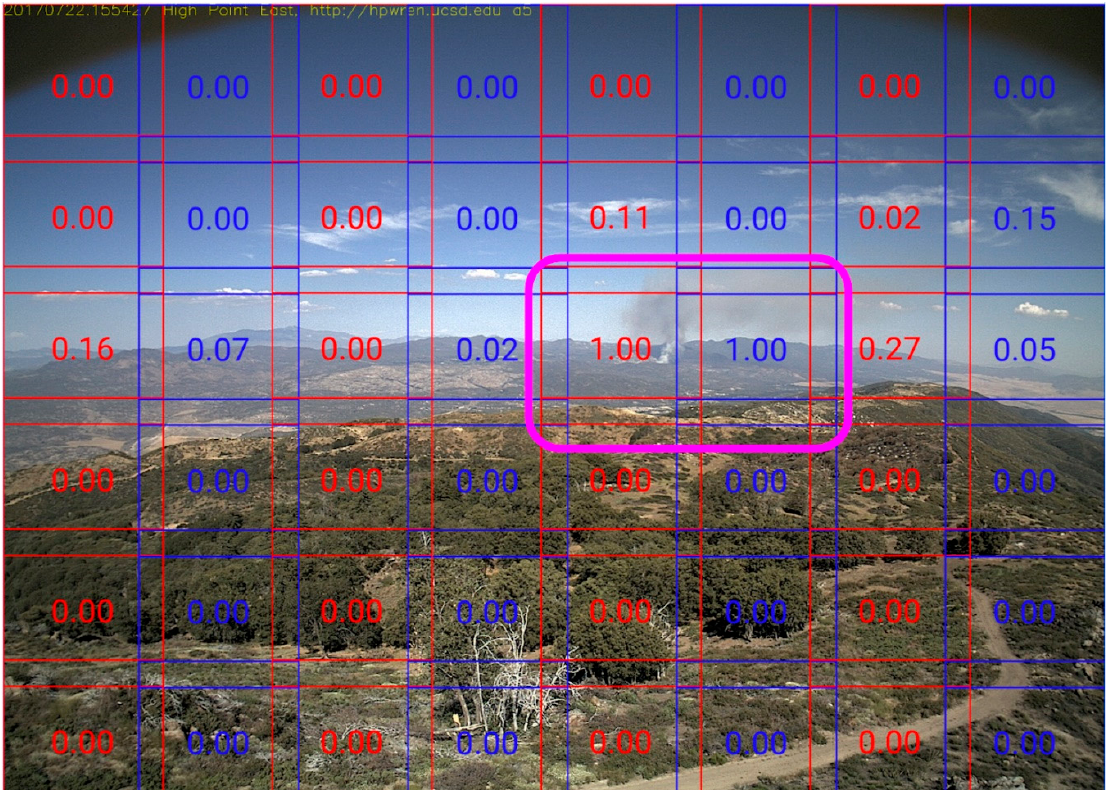
Figure 3. The red and blue grid lines show the overlapping 299 × 299 squares (two different colors were chosen to make it easier to see the boundaries). The red and blue numbers are the scores returned from the ML inference engine for those corresponding square segments. The two squares highlighted in purple contain a significant amount of smoke and are the only squares that scored above